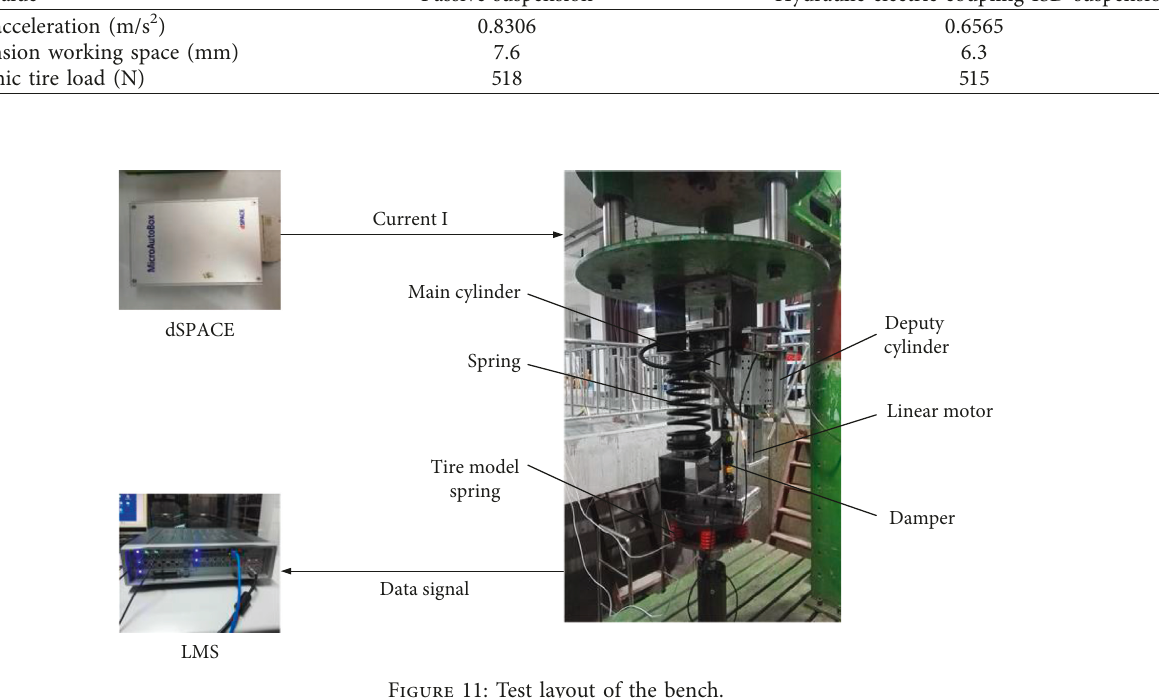
Figure 11: Test layout of the bench.